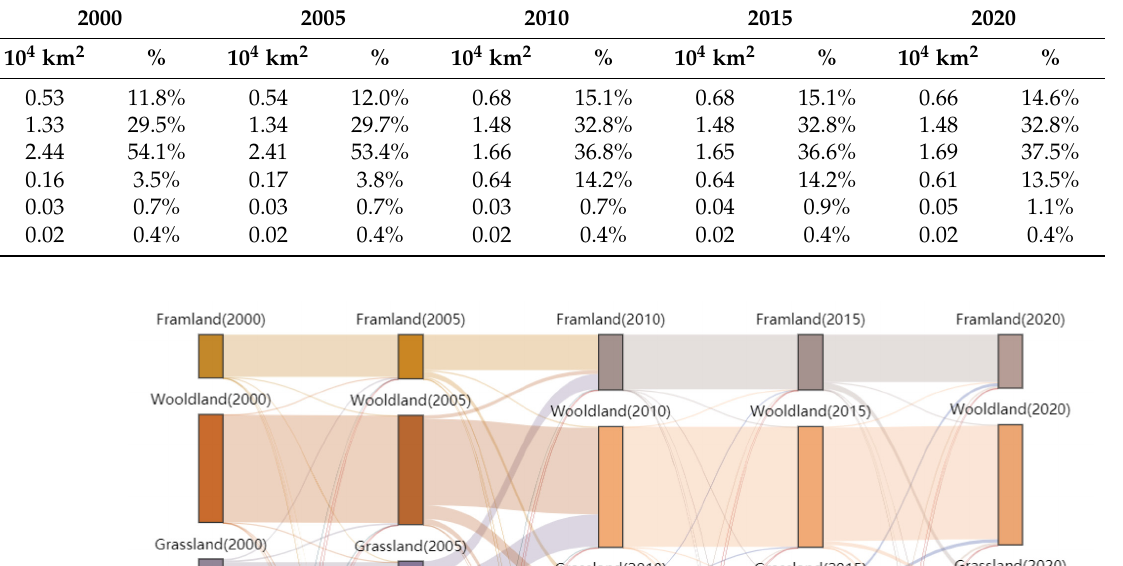
Table 4. Land use change in forest–steppe ecotone from 2000 to 2020.